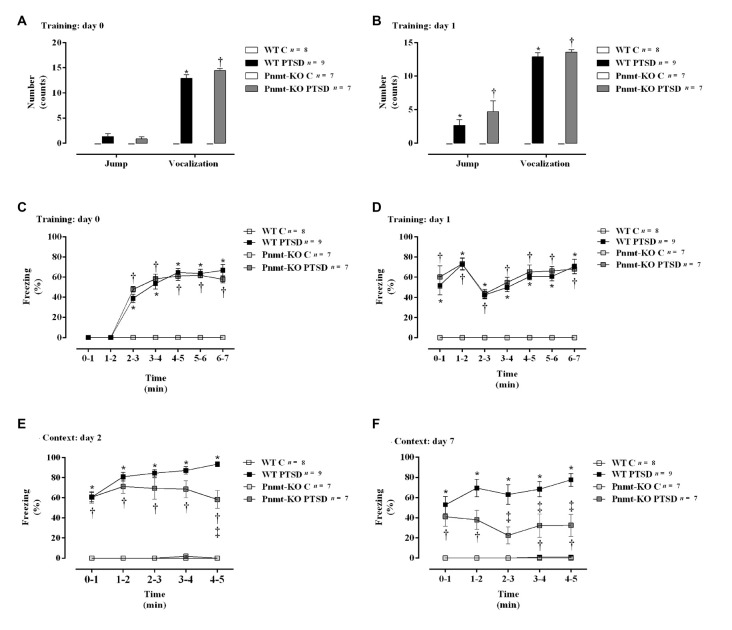
(A,B) Shock responsivity on training sessions (days 0 and 1) and (C–F) freezing behavior during induction of PTSD. Freezing on (C) day 0, (D) day 1, (E) day 2, and (F) day 7 in WT and phenylethanolamine-N-methyltransferase-knockout (Pnmt-KO) mice in the PTSD-induction group or not (control, WT C and Pnmt-KO C). Values are means ± SEM of 7–9 mice per group. C, control mice, placed in the same chamber during the same amount of time and days as the other mice but were not induced with PTSD; WT C, WT control mice; WT PTSD, WT mice in the PTSD-induction group; Pnmt-KO C, Pnmt-KO control mice; Pnmt-KO PTSD, Pnmt-KO mice in the PTSD-induction group. *Significantly different from correspondent values in WT control mice (p < 0.05). †Significantly different from correspondent values in Pnmt-KO control mice (p < 0.05). ‡Significantly different from correspondent values in WT mice with similar pathology (p < 0.05).